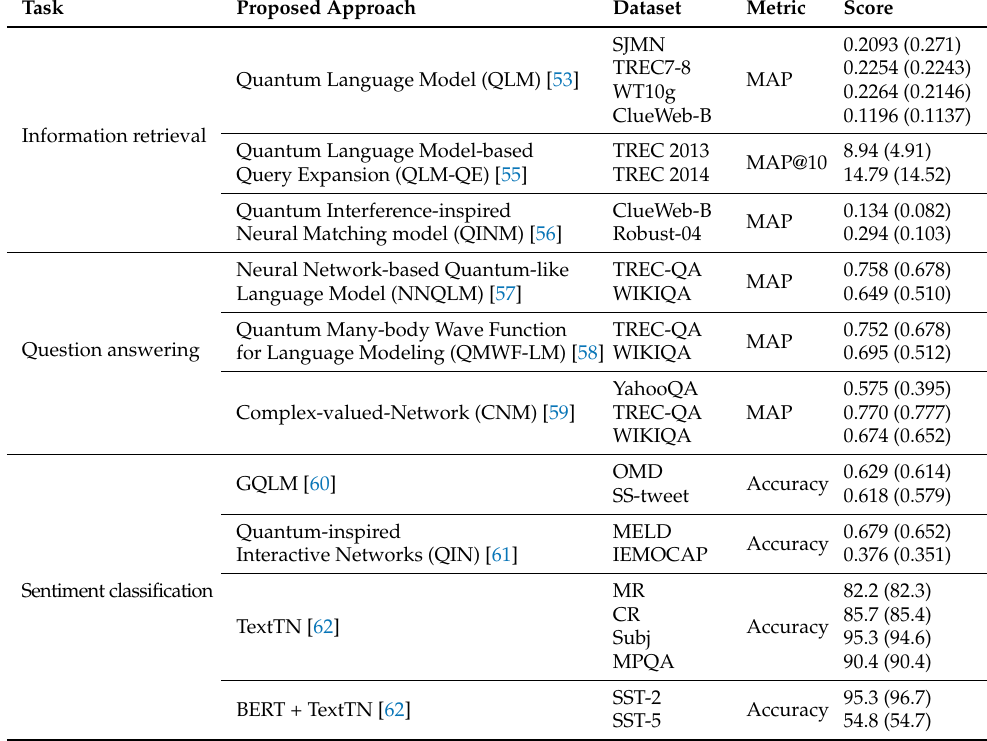
Table 2. Comparison of quantum-inspired approaches running on classical hardware. Since a real comparison is not always possible, only the works that have really compared with benchmark datasets already known in the literature are shown. For each model proposed, the best score obtained for the metric used with respect to the specific dataset is shown in the last column. In brackets, the best score obtained by the baseline with which each approach has been compared is